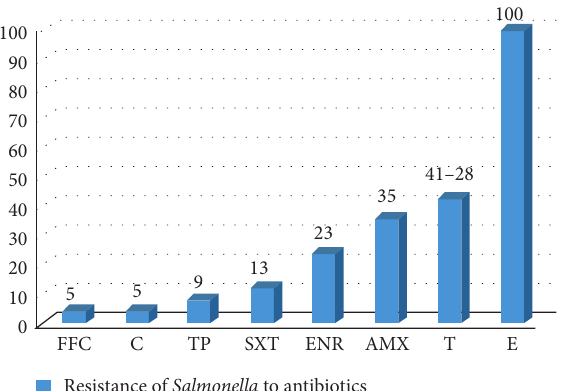
Figure 3: Percentage of Salmonella resistant to antibiotics. E, erythromycin; T, oxytetracycline; AMX, amoxicillin; ENR, enro- floxacin; SXT, trimethoprim-sulfamethoxazole; TP, trimetho- prime; C, colistin; FFC, florfenicol.